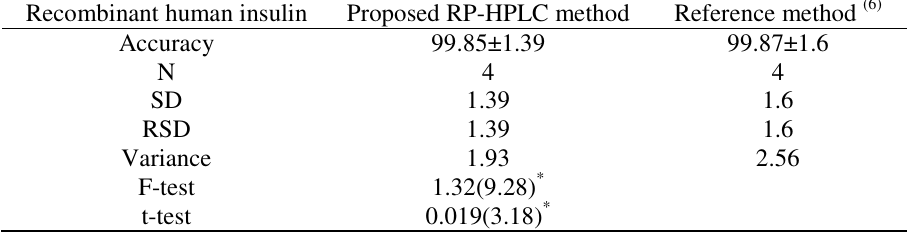
Table 10. Statistical comparison between the modified and reference RP-HPLC methods for determination of recombinant